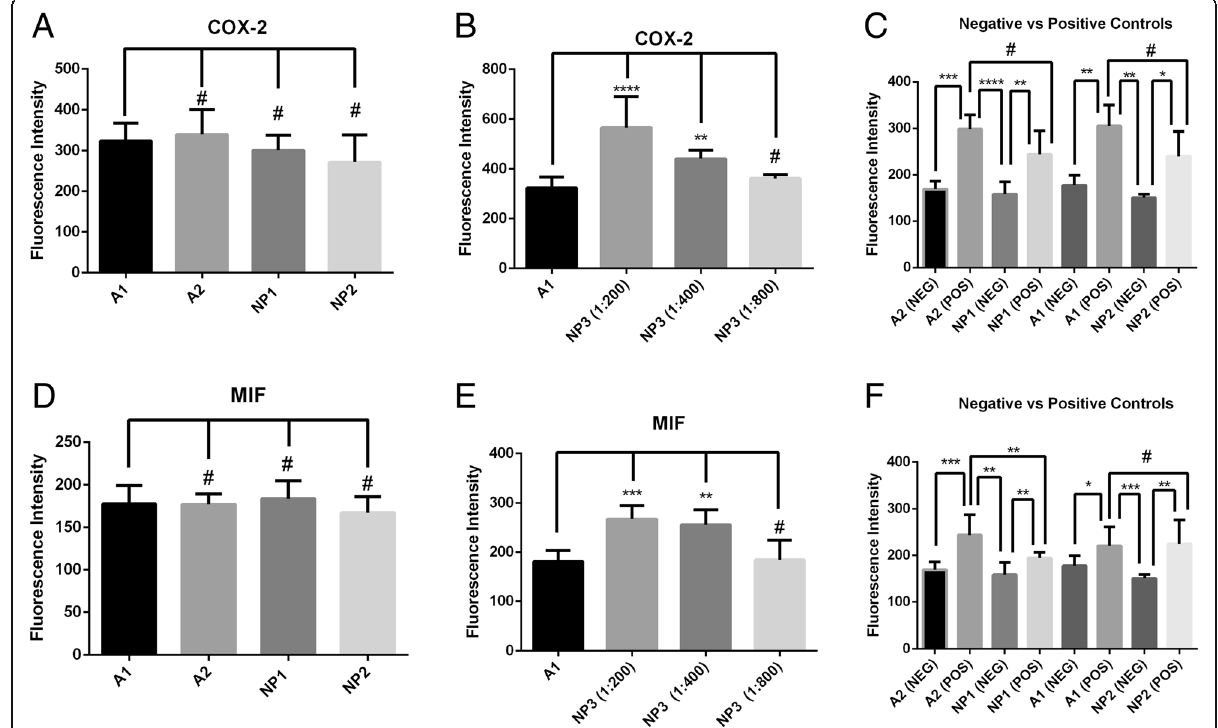
Fig. 2 Comparison of fluorescence intensity among groups. a Fluorescence intensity of AuNPs in A2, NP1, and NP2 in comparison to A1-only acetic acid-induced UC (anti-COX-2 antibody). b All dilutions of NP3 (1:200, 1:400, and 1:800) in comparison to the fluorescence intensity of A1 (1:400)-only acetic acid-induced UC (anti-COX-2 antibody). c Comparison of the fluorescence intensity among acetic acid-induced animals and negative controls after short-time (A2 and NP1) and overnight incubation (A1 and NP2). d Fluorescence intensity of AuNPs in A2, NP1, and NP2 in comparison to A1-only alcohol-induced steatohepatitis (anti-MIF antibody). e All dilutions of NP3 (1:200, 1:400, and 1:800) in comparison to the fluorescence intensity of A1 (1:400)-only alcohol-induced of steatohepatitis (anti-MIF antibody). f Comparison of the fluorescence intensity among alcohol-induced steatohepatitis animals and negative controls after 30-min incubation (A2 and NP1) and overnight incubation (A1 and NP2). Statistics: ANOVA and Bonferroni ’ s post hoc test, # p ≥ 0.05, ** p < 0.01,*** p < 0.001, and **** p < 0.0001